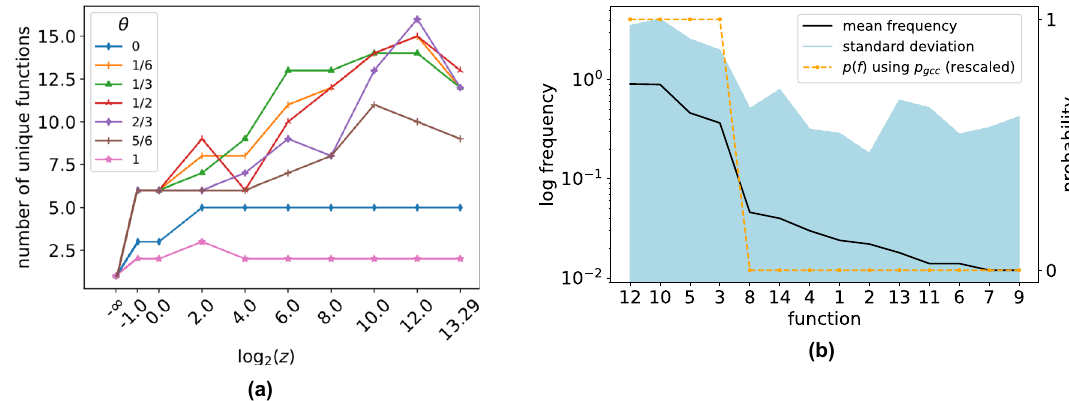
Figure 4. Antagonism fraction ( θ ) agrees with biology; non-monotone functions also predicted by path requirements. ( a ) For networks with N = 10000 nodes and k = 2 inputs, over 500 realizations, varying the 1 , 2 , . . . 1 } , we observe that the mean number of mean degree z and fraction of antagonistic nodes θ ∈ { 0, 6 6 3 , 2 10 ] unique functions per network is maximized over several orders of magnitude ( z ∈ [ 2 ) by networks having 1 1 2 6 , we a fraction of antagonistic nodes θ = 3 (triangles), coinciding with other findings 38 . ( b ) At θ = 3 and z = again observe a skewed frequency, and a proportional relationship between function frequency and probability due to complexity Eq. (4), having Pearson correlation of 0.91. Shaded region is one standard deviation. Probabilities have been centered and normalized. (Functions f 0 and f 15 have been removed, since in the ALTM they can occur outside of the